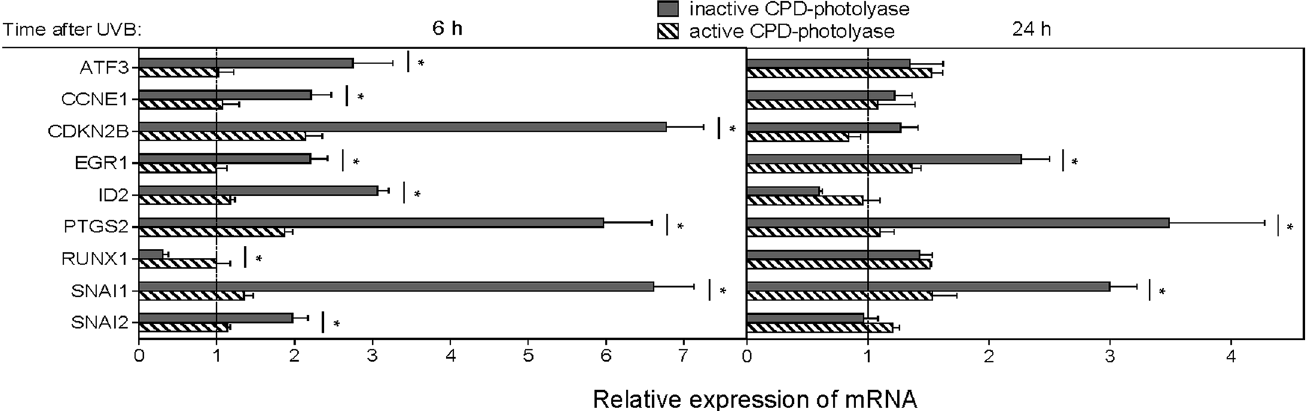
Fig 2. Experimental verification of microarray results for 9 selected genes. HaCaT cells were exposed to 20 mJ/cm 2 UVB at 12 h after delivery of CPD-PL Ψ -mRNA. Immediately thereafter, cells were either subjected to photoreactivating light (active CPD-photolyase) or left in the dark (inactive CPD- photolyase) for 1 h. Following incubation total RNA was extracted at 5 and 23 h, then real-time RT-qPCR was performed to validate the CPD-dependent expression of ATF3, CCNE1, CDKN2B, EGR1, ID2, PTGS2, RUNX1, SNAI1 and SNAI2. Values measured in UVB irradiated cells with or without photoreactivation were related to those measured in non-UVB irradiated cells that were transfected control Ψ -mRNA, (pecked lines). Asterisks indicate significant differences (two-tailed, unpaired t -test; p < 0.05) between photoreactivated (active CPD-photolyase) and non-photoreactivated (inactive CPD- photolyase) samples. The results of RT-qPCR are means ± SEM from three independent experiments in